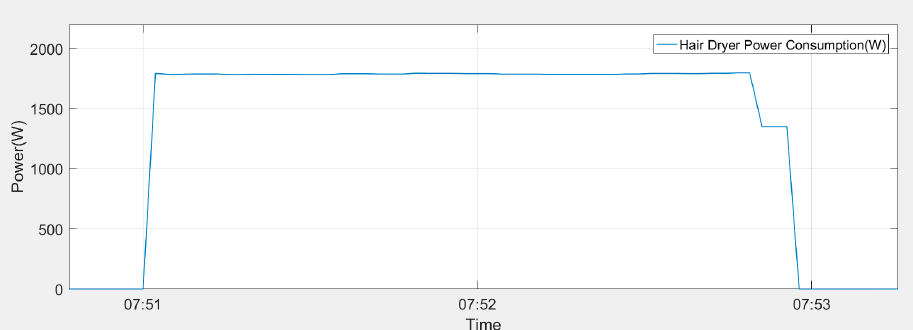
Figure 13. The power consumption curve of the hair dryer in high-speed blowing mode.